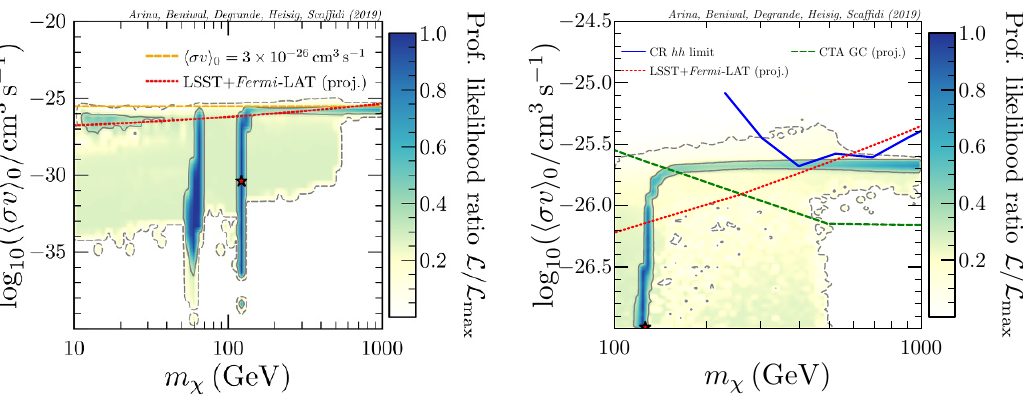
Figure 7 . Left panel : 2D PLR plots for the pNG DM annihilation cross section today af- ter post-processing our samples with Fermi -LAT likelihood for 41 dSphs. Projected limits from LSST+ Fermi -LAT dSphs [90] are shown as dotted red curve. Right panel : same as the left panel, except for m (cid:31) [100 ; 1000] GeV. The solid blue curve shows the current cosmic-ray (CR) antipro- 2 ton limit for the (cid:31)(cid:31) hh channel [91]. Projected limits from CTA Galactic Centre (GC) [92] ! (dashed green), and LSST+ Fermi -LAT dSphs [90] (dotted red) for the bb channel are also